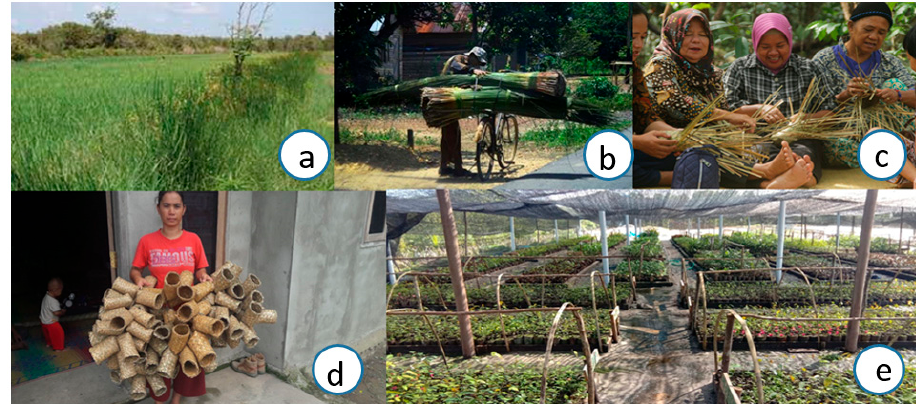
Figure 4. Utilisation of Eleocharis dulcis (purun tikus) as bio pots to reduce the use of polybags (Photo credit: Bastoni and Purwanto, 2021): ( a ) native E. dulcis ; ( b ) transporting E. dulcis to the village; ( c ) organic pot production by women; ( d ) organic pots of purun; ( e ) utilisation of organic pots for native tree seedling production.